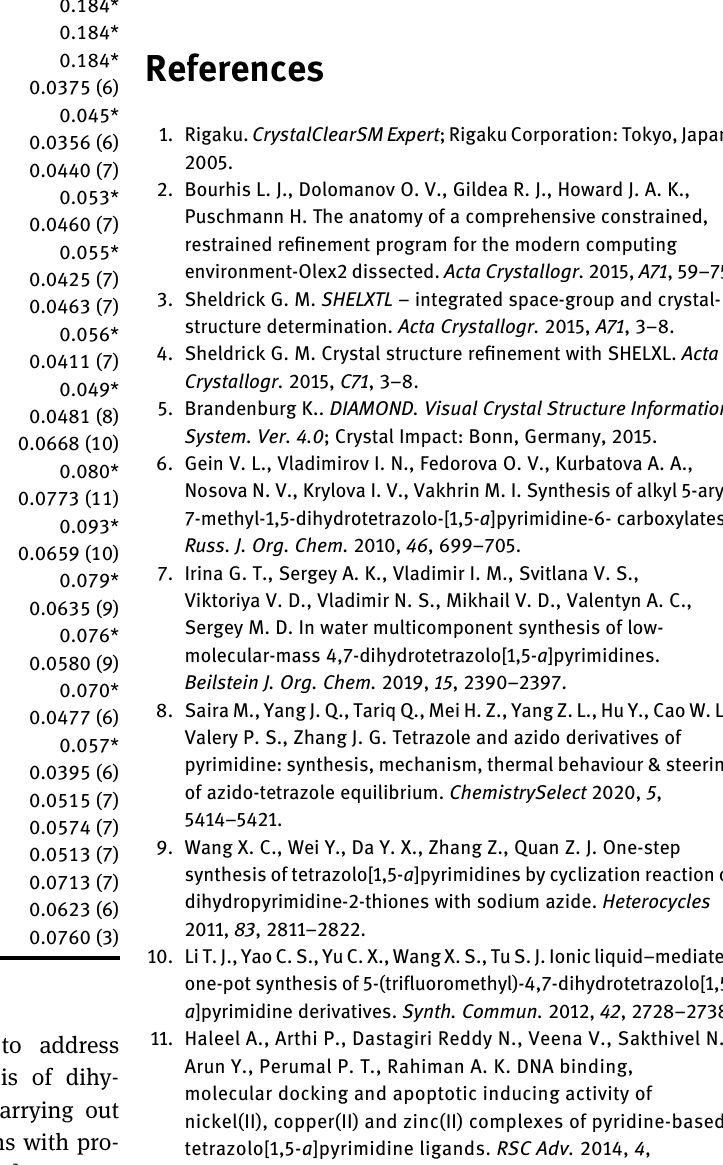
In the title molecule all bond lengths are in normal ranges [13 – 15]. The plane of the tetrazole forms dihedral angles of 10.8(1) ° and 87.43(9) ° with the two phenyl rings. The dihedral angle between the phenyl rings is 81.8(1) ° . The pyrimidine ring is in a fl attened boat conformation. In the crystal, N – H ⋯ N hydrogen bonds connect adjacent mole- cules into dimers.